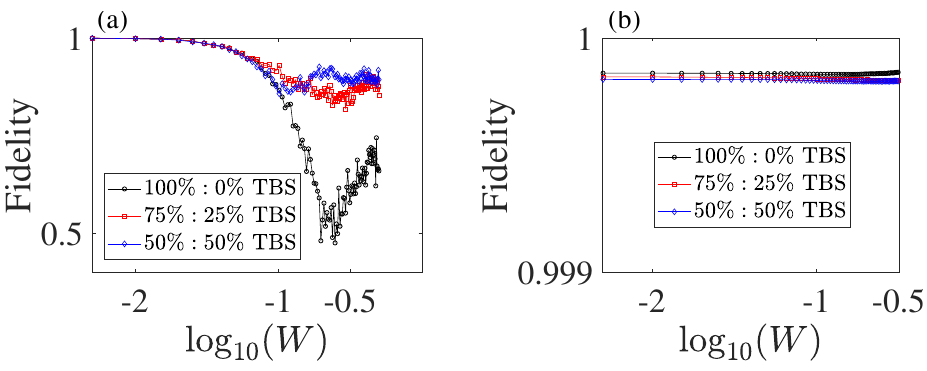
Figure 7. The fidelities of different TBSs when the random disorder is added into the system. Note that we neglect the phase information of the evolved final state in the process of calculating the fidelity. ( a ) The random disorder is added into the nearest neighbor hopping. ( b ) The random disorder is added into the on-site energy. Other parameter takes N =